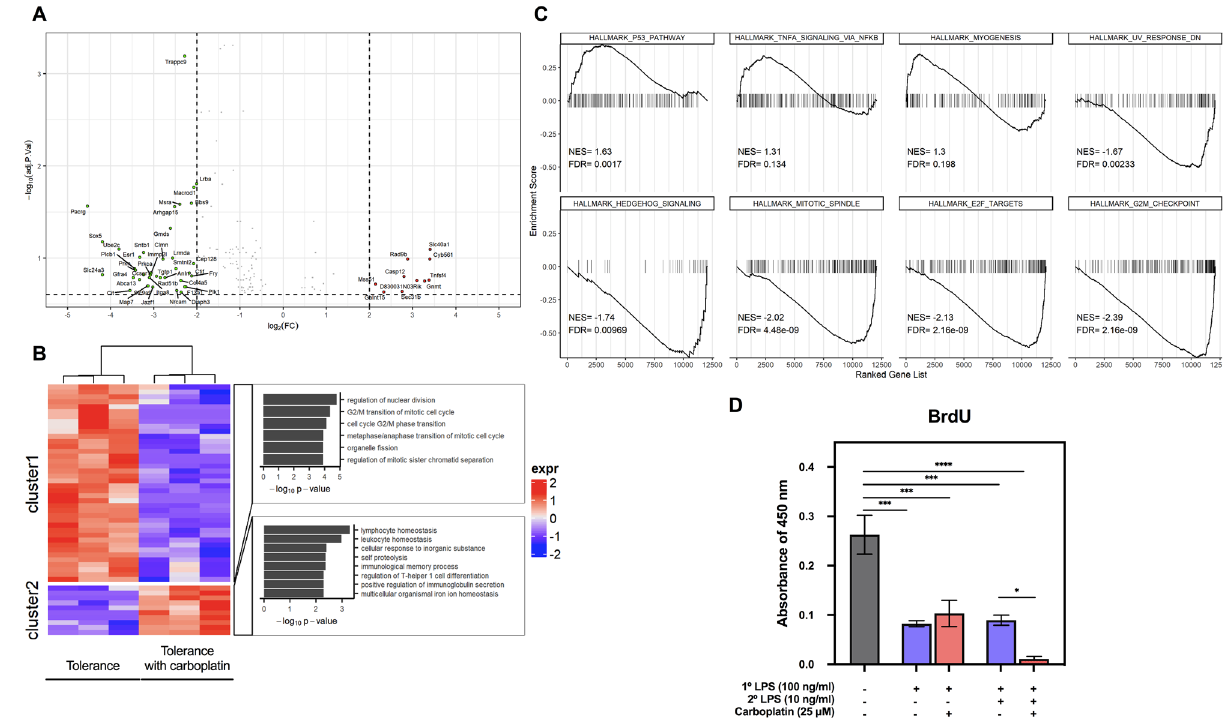
Figure 4. Transcriptomics of LPS-tolerant macrophages in the presence of carboplatin. ( A ) BMDMs were pretreated with or without carboplatin (25 μM) for 1 h before stimulation with LPS (100 ng/ml) for 24 h. The medium was removed, and fresh medium with LPS (10 ng/ml) was added to induce LPS-tolerant macrophages. RNA was harvested at 3 h, and RNA-Seq was performed as described in the “Materials and methods”. Volcano plot showing differentially expressed genes of LPS-induced tolerant macrophages with or without carboplatin. |log2FC| > 2, p < 0.25. ( B ) Heatmap and GO terms associated with differentially expressed genes. ( C ) GSEA showing positive and negative hallmark gene sets in LPS-induced tolerant macrophages treated with carboplatin. ( D ) A BrdU incorporation assay was performed using carboplatin-treated LPS-primed and LPS- tolerant macrophages for 24 h. *, **, ***, **** indicate p < 0.05, p < 0.01, p < 0.001, p < 0.0001, respectively, using one-way